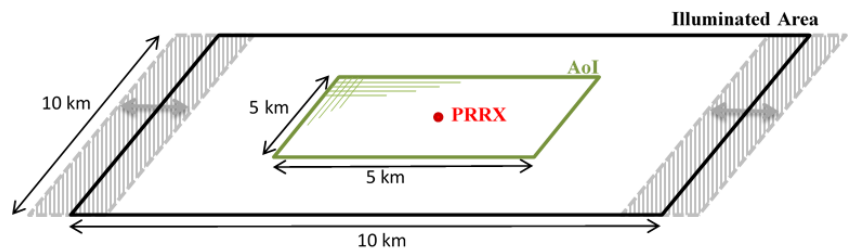
Figure 20. Case study geometry analysis scheme.